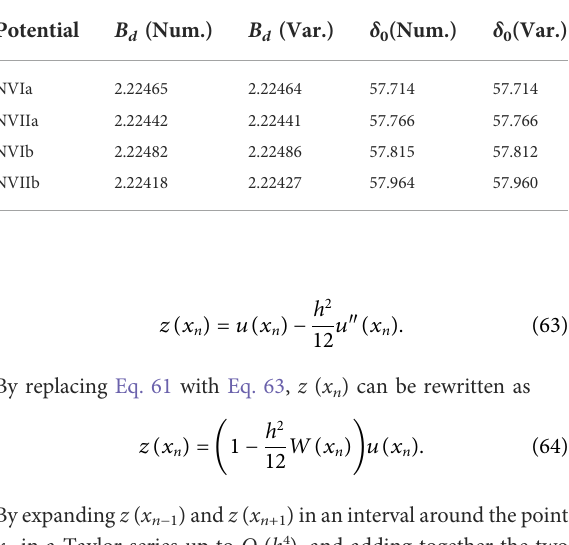
TABLE 1 Deuteron binding energies B d , in MeV, and nn S -wave phase shift δ 0 at E =5 MeV,indeg,calculatedwiththeNumerov(Num.)or the variational (Var.) methods using the four Norfolk chiral potentials NVIa, NVIIa, NVIb, and NVIIb. Here, we report the results up to the digitfromwhichthetwomethodsstarttodiffer.Theexperimental value for B d is B exp d (cid:2) 2 . 2245